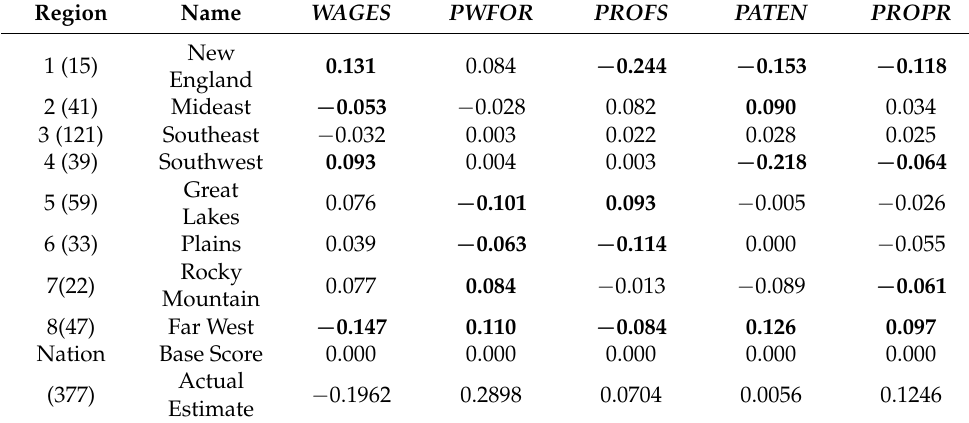
Table 7. Pooled Standard Scores for the Four Employment